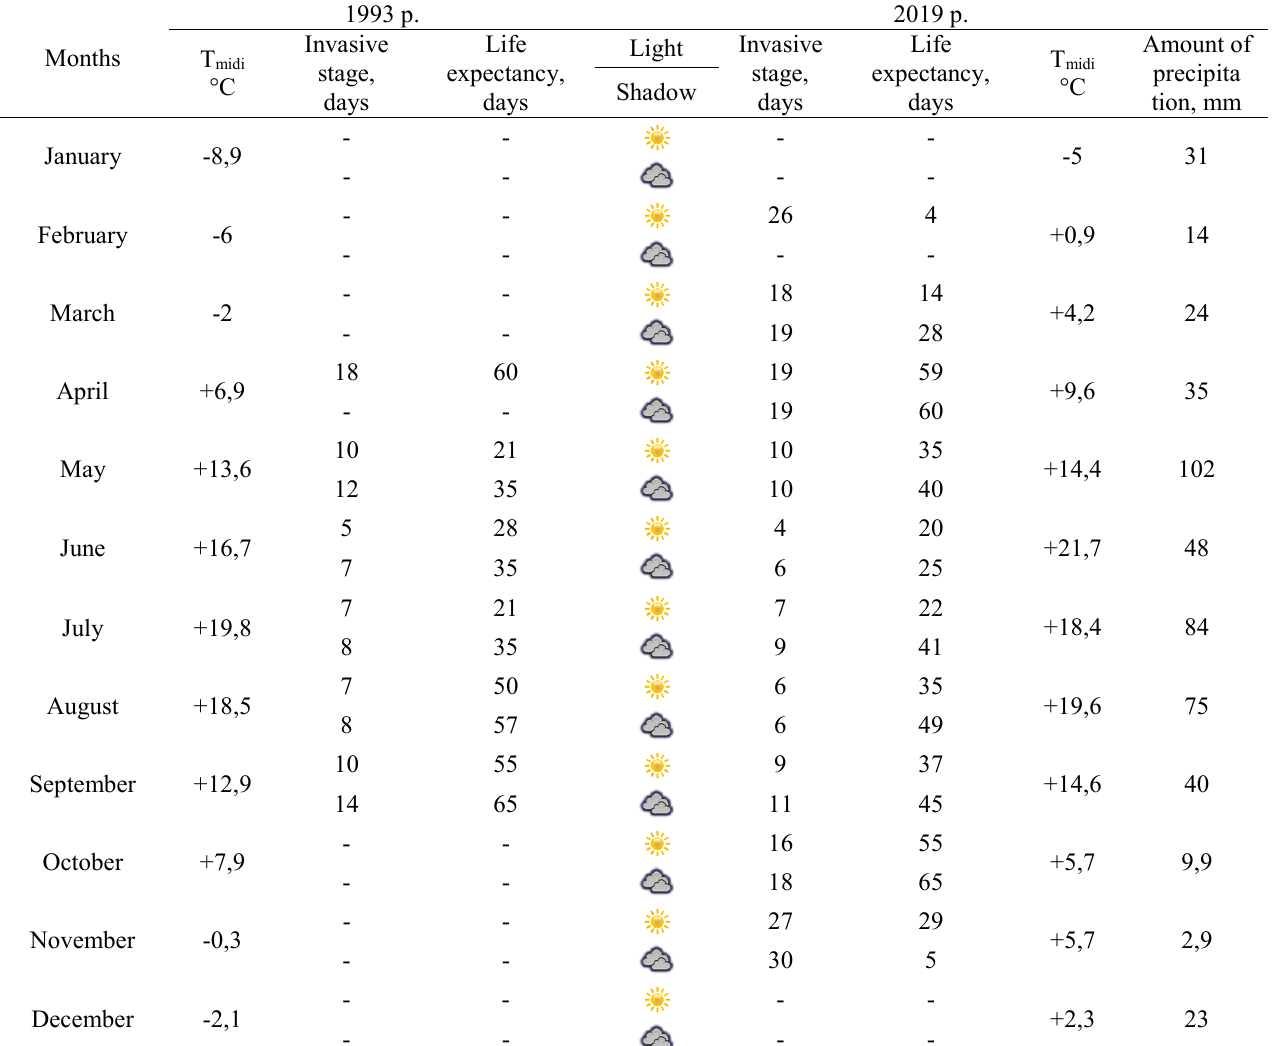
Terms of maturation and survival of dictiocaulus